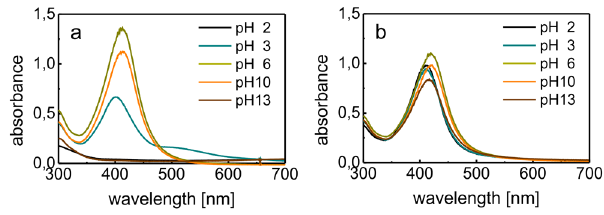
Figure 3. UV/vis absorption spectra of the unmodified (a) and gelatin-modified (b) AgNPs reduced by maltose at various pH values.